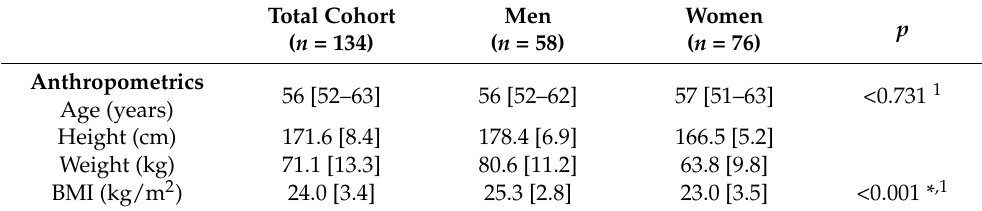
Table 3. Characteristics of the study population.